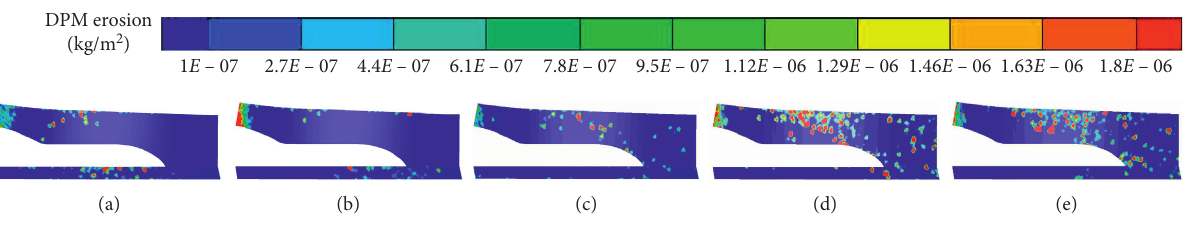
Figure 15: Suction surface wear clouds at different particle volume concentrations. (a) C � 10%, (b) C � 15%, (c) C � 20%, (d) C � 25%, and (e) C � 30%.